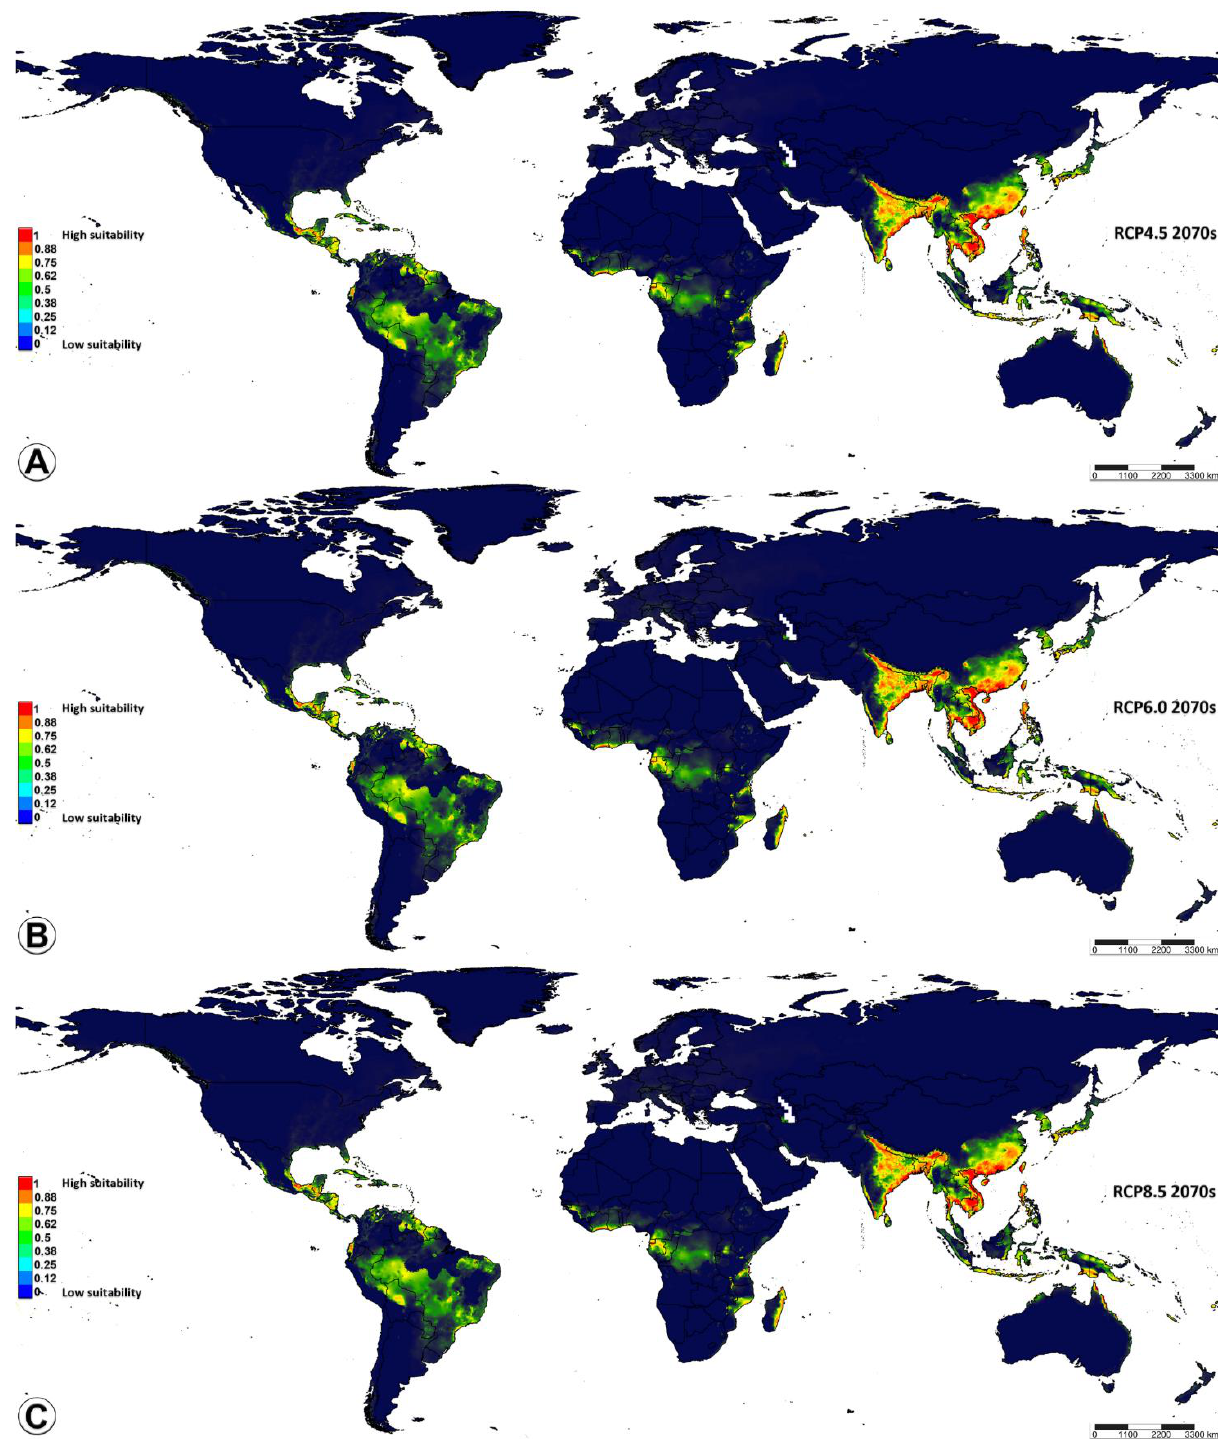
Figure 7. Potential distribution of Microplitis manilae under three climate change scenarios in the period of 2070s. ( A – C ) Future suitable distribution in a global context under three scenarios: ( A ) RCP4.5; ( B ) RCP6.0; ( C ) RCP8.5. High-suitability areas have a probability of 1 – 0.75; medium-suitability areas have a probability of 0.75 – 0.5; low-suitability areas have a probability of 0.5 – 0.25; unsuitable areas have a probability of 0.25 – 0. RCP = representative concentration pathways.